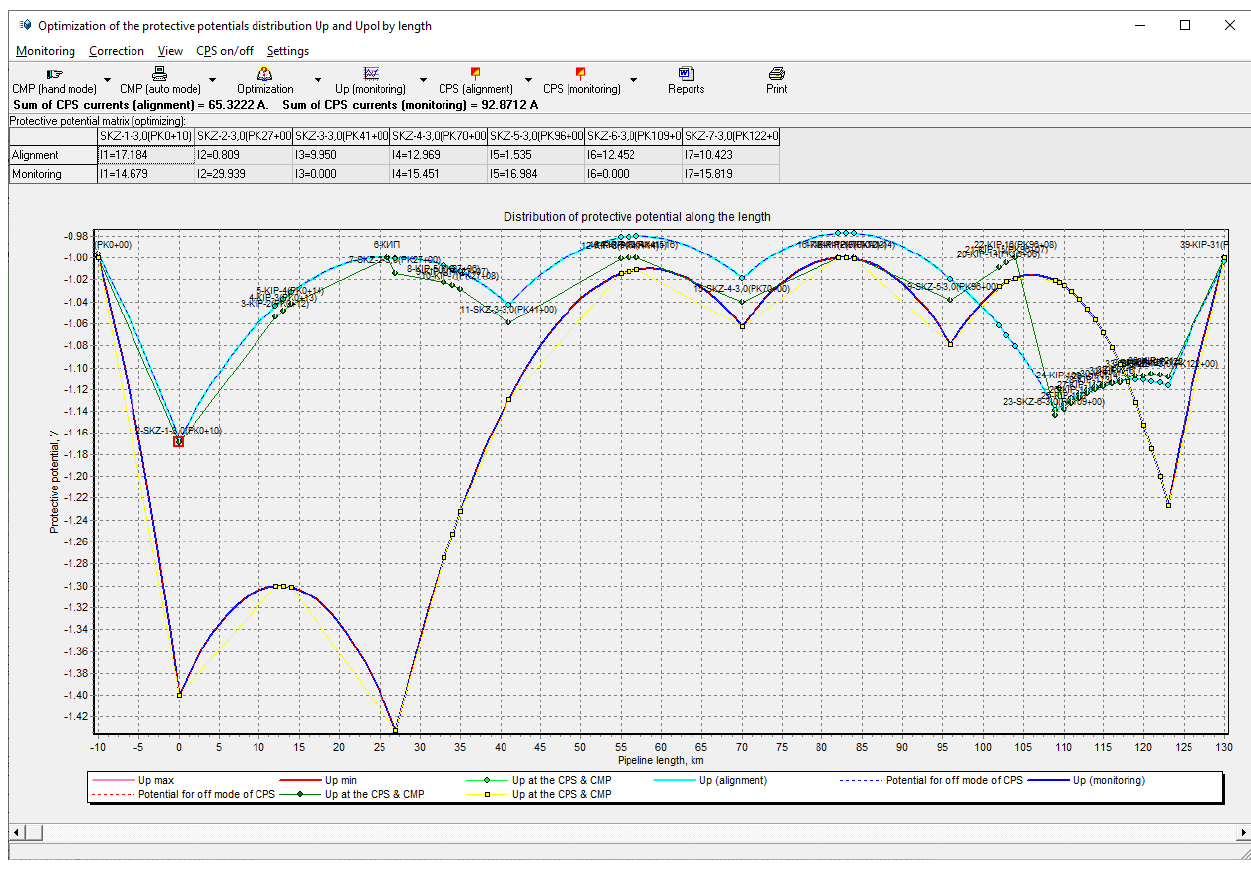
Figure 9. A new plan for the distribution of the total potential along the area under consideration, with correction from above according to Up min and from below Up max.